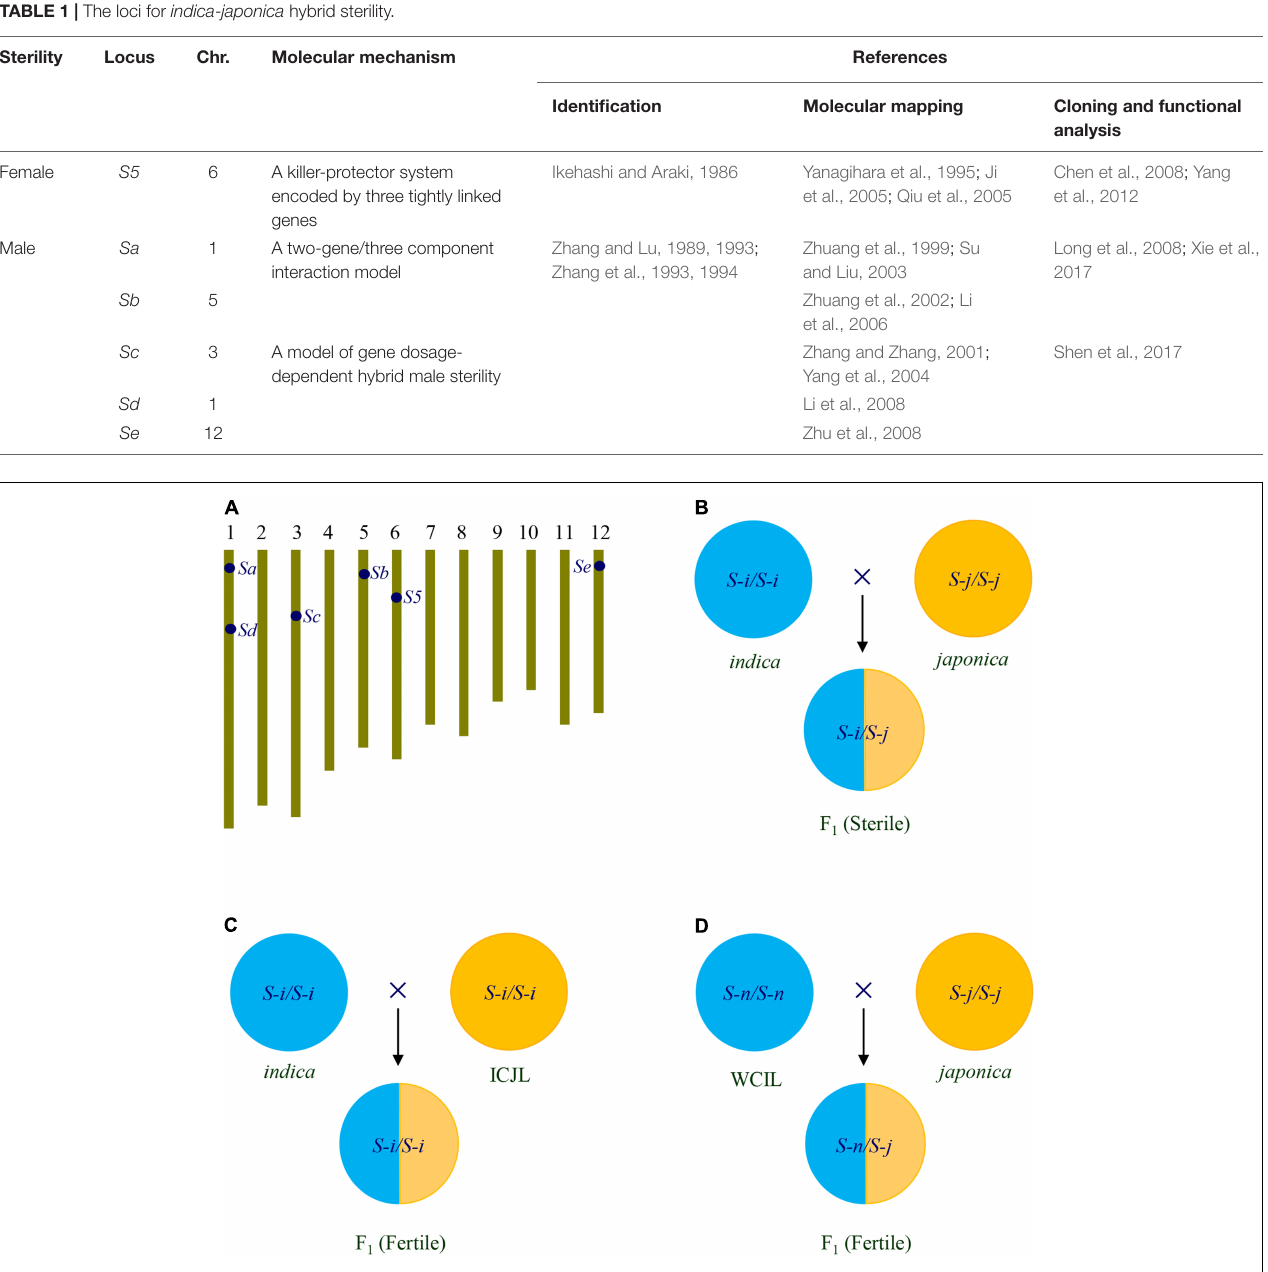
FIGURE 1 | Strategies for overcoming indica - japonica hybrid sterility. (A) Chromosomal location of the S5 , Sa , Sb , Sc , Sd, and Se loci for indica - japonica hybrid sterility. (B) Hybrid of indica / japonica is sterile, which is caused by the interaction between S-i and S-j at the S5 , Sa , Sb , Sc , Sd, and Se loci. (C) Hybrid of indica /ICJL is fertile due to ICJL carrying S-i at the S5 , Sa , Sb , Sc , Sd, and Se loci. (D) Hybrid of WCIL/ japonica is fertile due to WCIL carrying S-n at the S5 , Sa , Sb , Sc , Sd, and Se loci. ICJL, indica -compatible japonica line; WCIL, wide-compatible indica line.